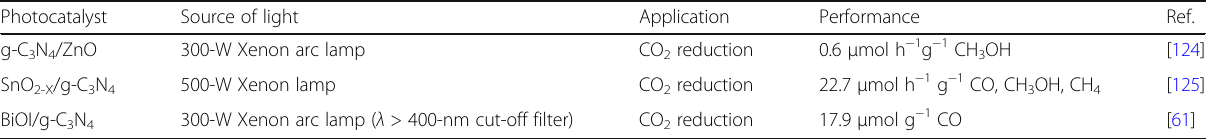
Table 3 Studies of g-C 3 N 4 heterojunctions on Carbon dioxide (CO 2 ) reduction Photocatalyst